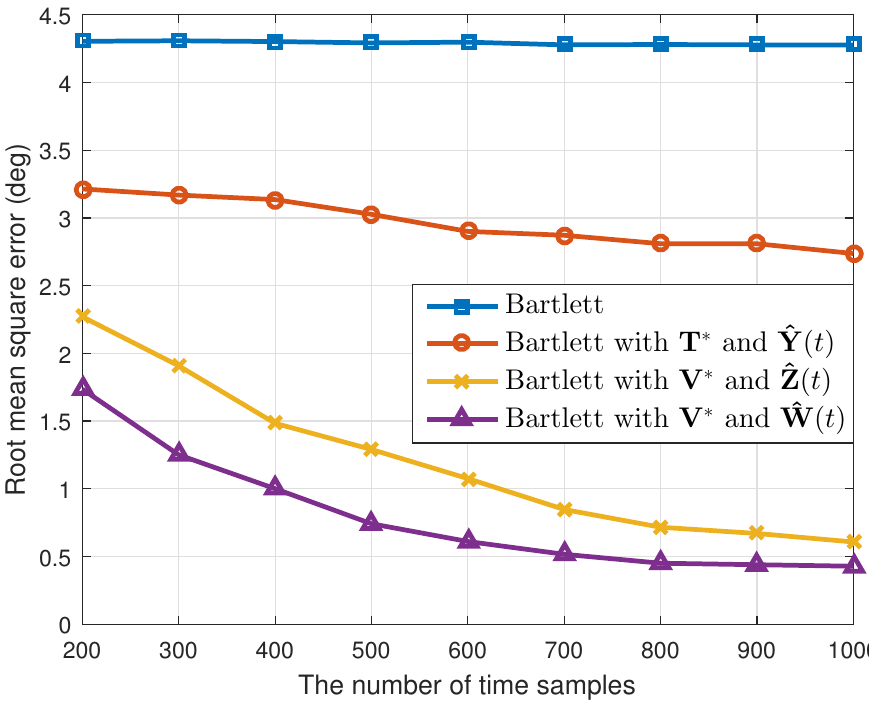
Figure 6. Root mean squared errors versus the number of time samples (SNR is 10